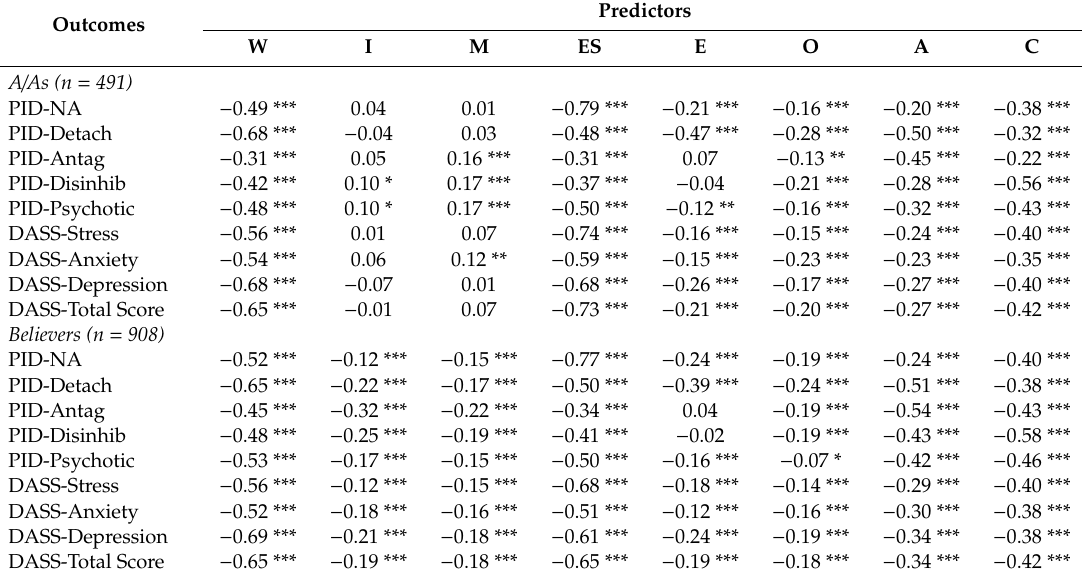
Table 3. Correlations Between Personality, Worthiness, and the Depression, Anxiety, and Stress Scale (DASS) and Personality Inventory for DSM-5 (PID-5) Scales Separately by Faith Status. Outcomes